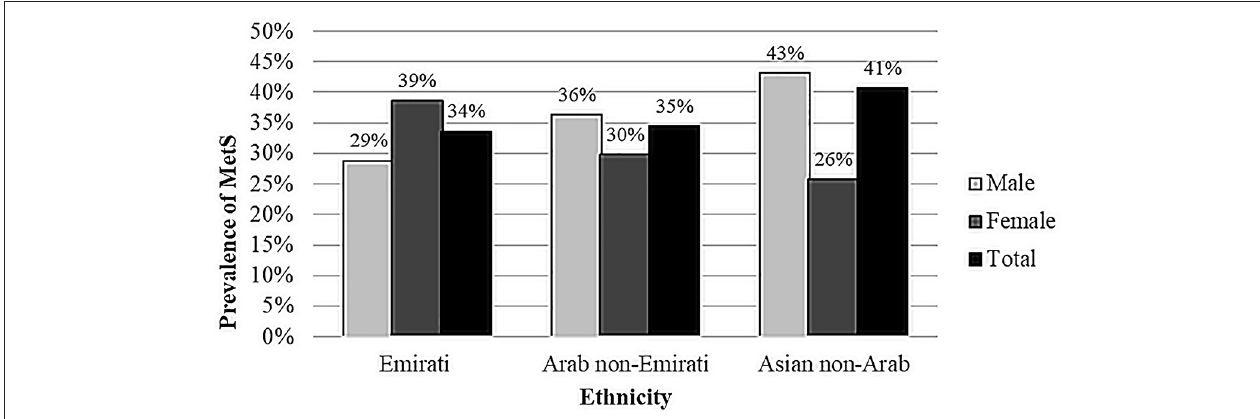
FIGURE 2 | Gender and ethnicity-specific prevalence of metabolic